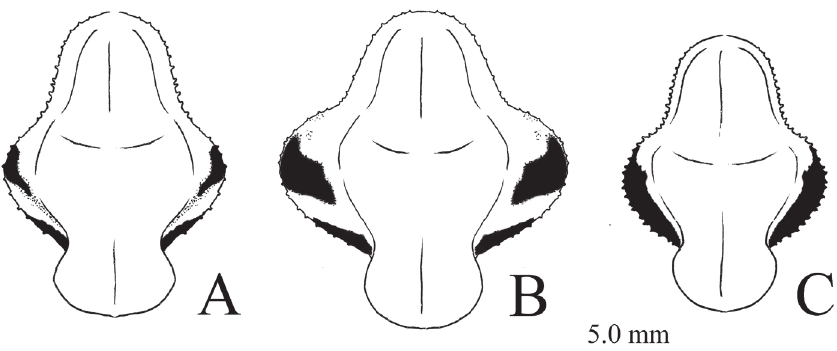
Figure 7. Pronotum of female Theopropus spp. in dorsal view A T. sinecus sinecus from Guangxi B T. xishi- ae sp. nov. paratype C T. sp. from Yunnan.